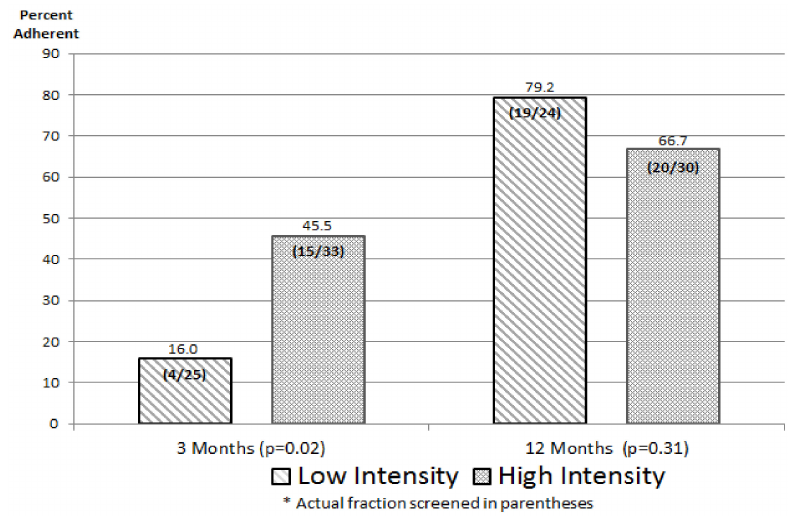
Figure 3. Intervention Impact on Mammography Screening Adherence Rates for Breast Cancer Survivors